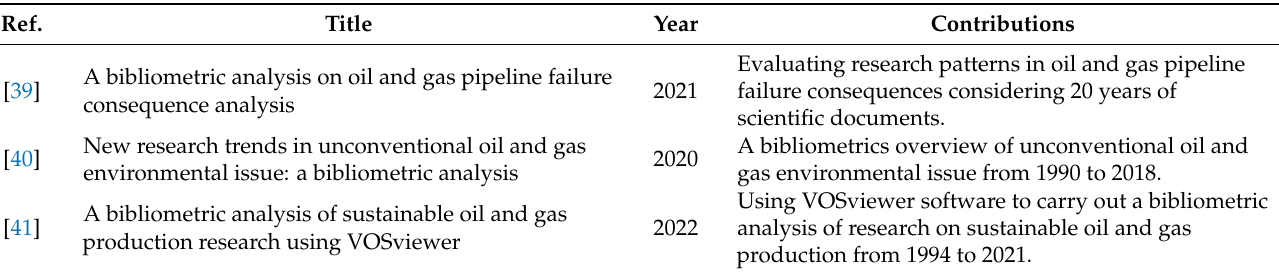
Table 1. Bibliometric studies in oil and gas well